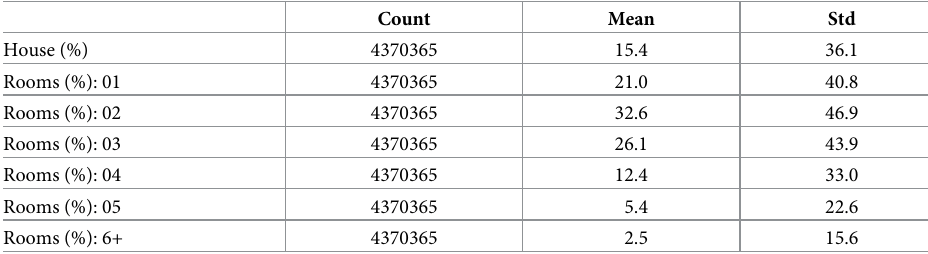
Table 3. Type of units, number of rooms and